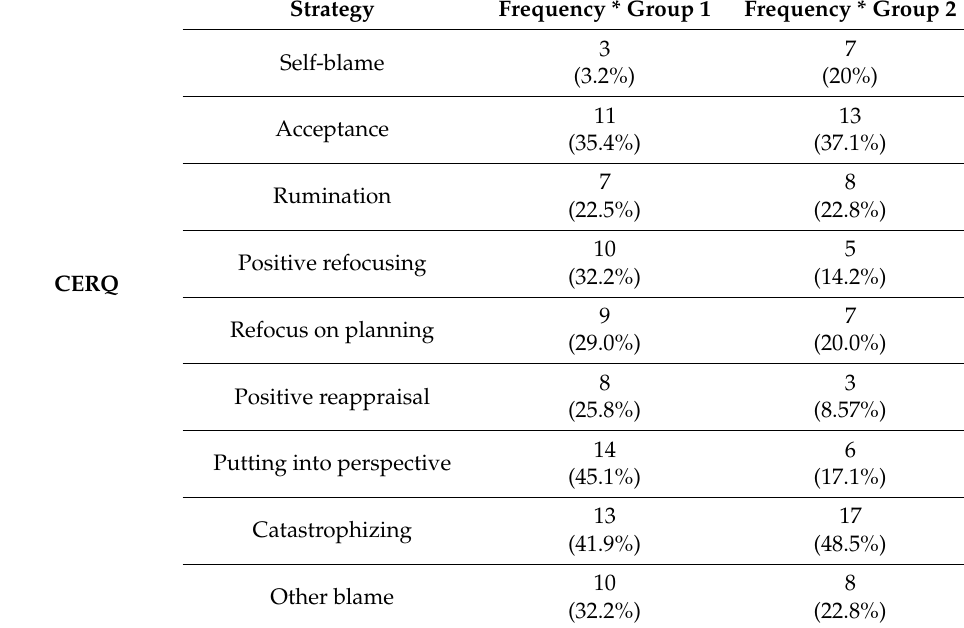
Table 5. Highest score frequency for each CERQ